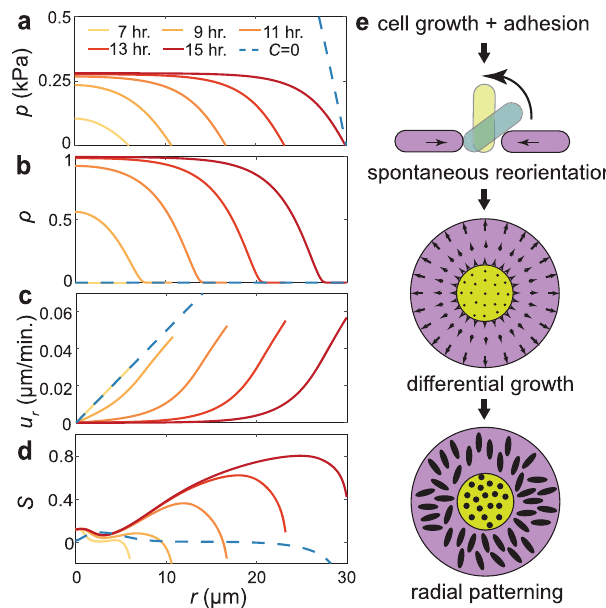
Fig. 4 A two-phase active nematic model predicts the spontaneous generation of differential proliferation and macroscopic cell organization. a – d Numerical solution of the model consisting of a population of horizontal and vertical cells. The bio fi lm was initiated with no vertical cells and random in-plane orientations. Evolution of pressure p ( a ), fraction of vertical cells ρ ( b ), in-plane radial velocity u ( c ), and radial order r parameter S ( d ). Curves are colored according to time. Results for a bio fi lm that cannot sustain verticalized cells ( C = 0) are shown in blue. e Schematic representation of the bio fi lm self-patterning process. Source data are provided as a Source Data fi